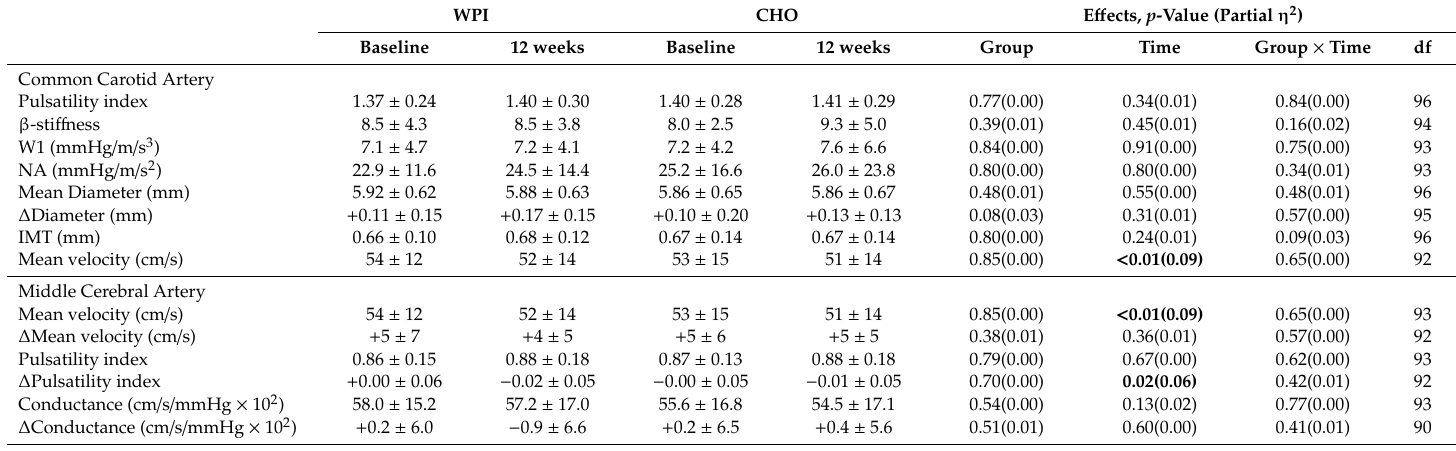
Table 4. Cerebrovascular hemodynamics at rest and in response to cognitive activity ( ∆ Stroop) at baseline and 12 weeks in WPI vs. CHO (mean ± SD). WPI CHO E ff ects, p -Value (Partial η 2 ) Baseline 12 weeks Baseline 12 weeks Group Time Group × Time df Common Carotid Artery Pulsatility index